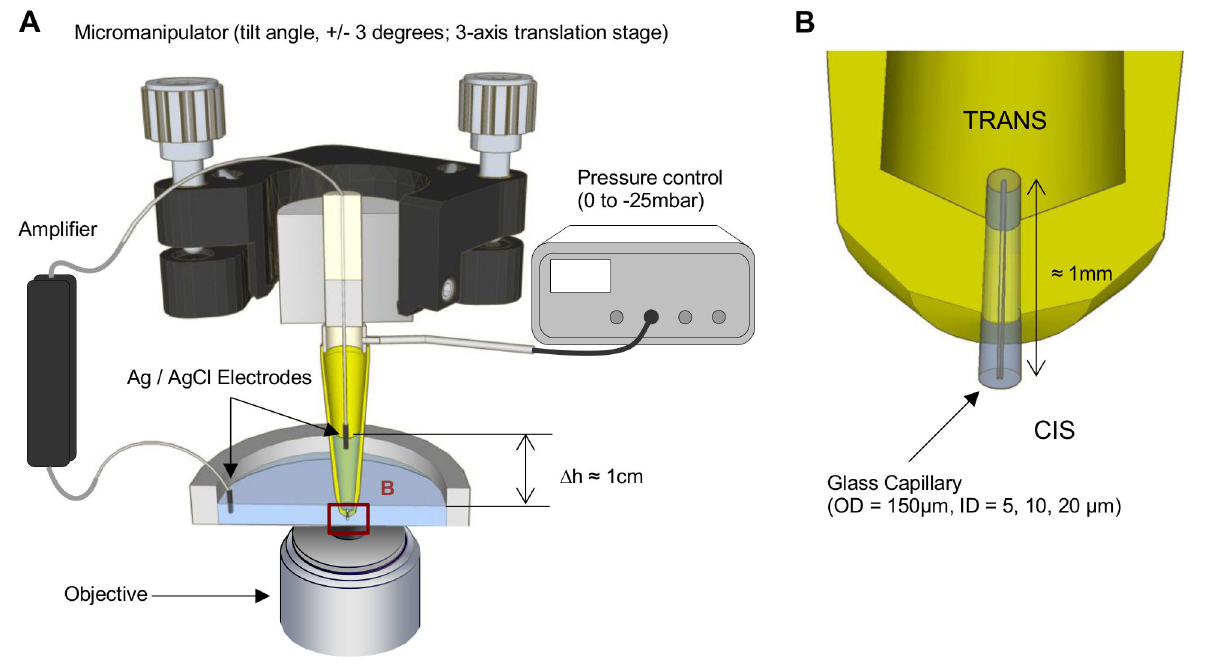
Figure 2. Capillary patch clamp setup. A\ Overview of the setup showing the chamber and the capillary pipette with associated voltage control (Axopatch 200-B), pressure control (MFCS) and micromanipulation devices (Newport). The pipette is cut in half for display purpose. B\ Zoom on the tip of the capillary pipette showing the inserted slice of capillary connecting cis and trans compartment. OD/ID: Outer/Inner